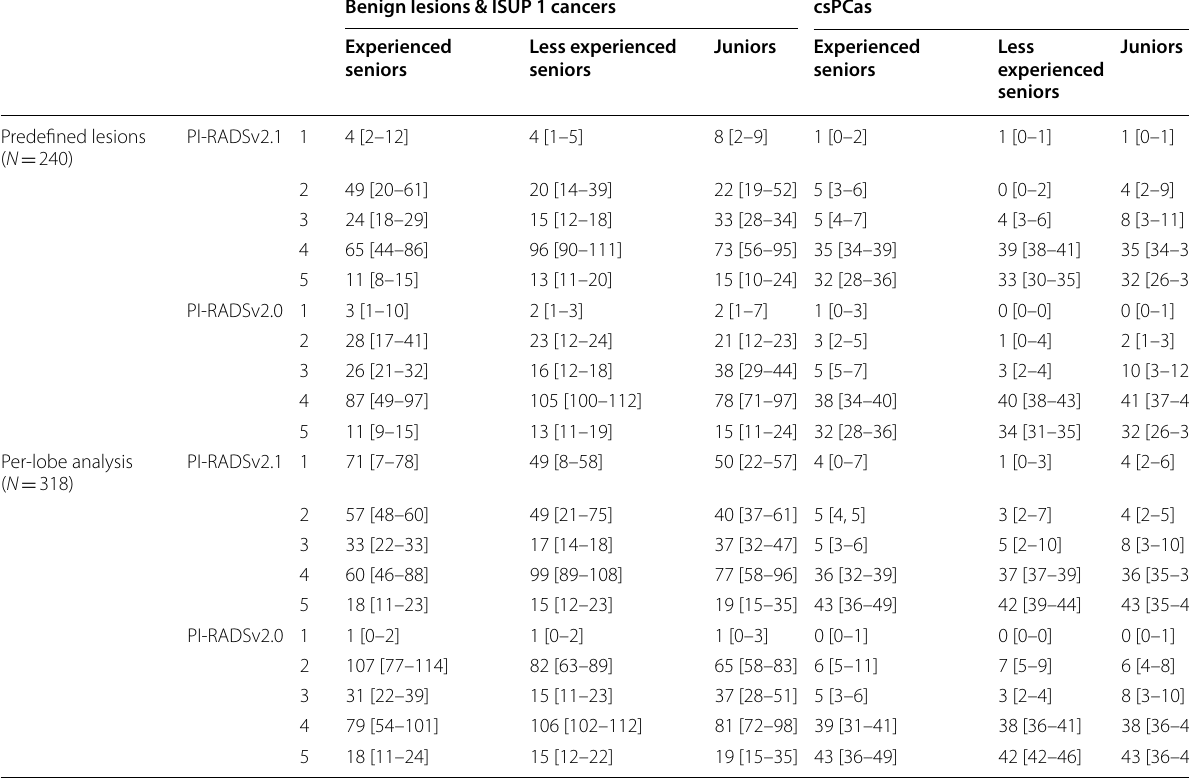
Table 3 PI-RADSv2.1 and PI-RADSv2 scores assigned by the three groups of